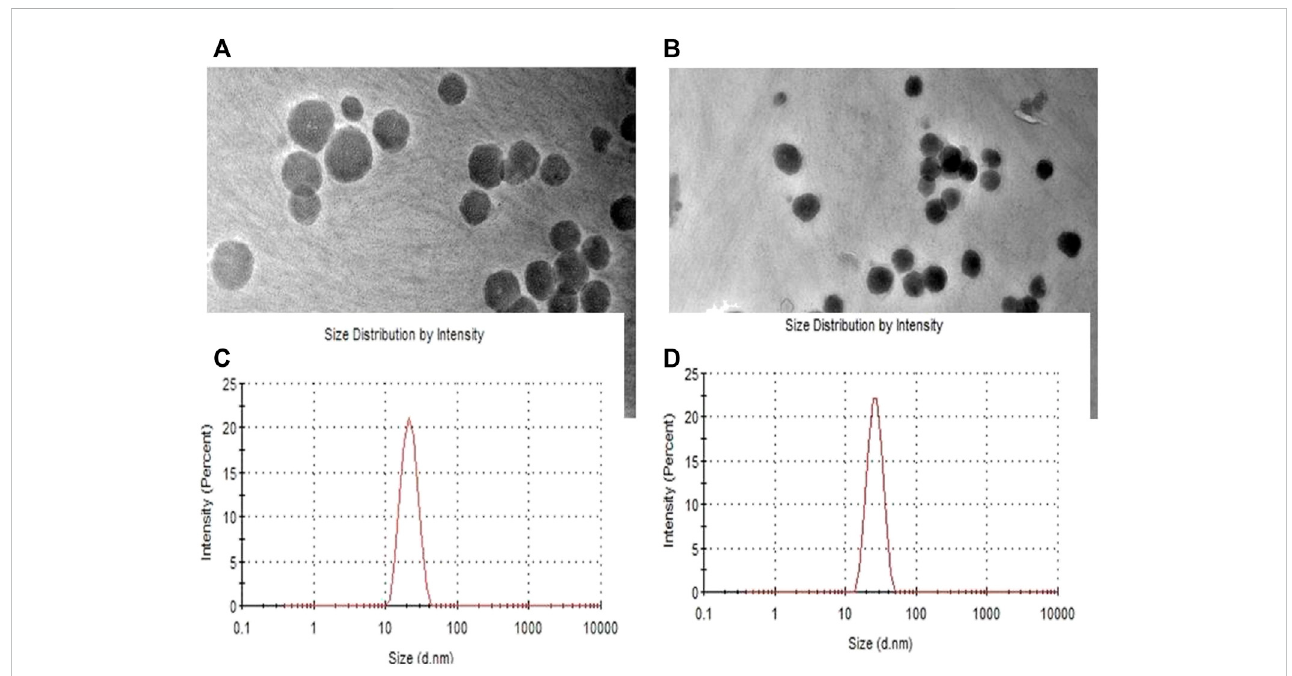
FIGURE 5 TEM images of (A) BLK-CUB and (B) ER-CUB (C) Size of BLK-CUB and (D)